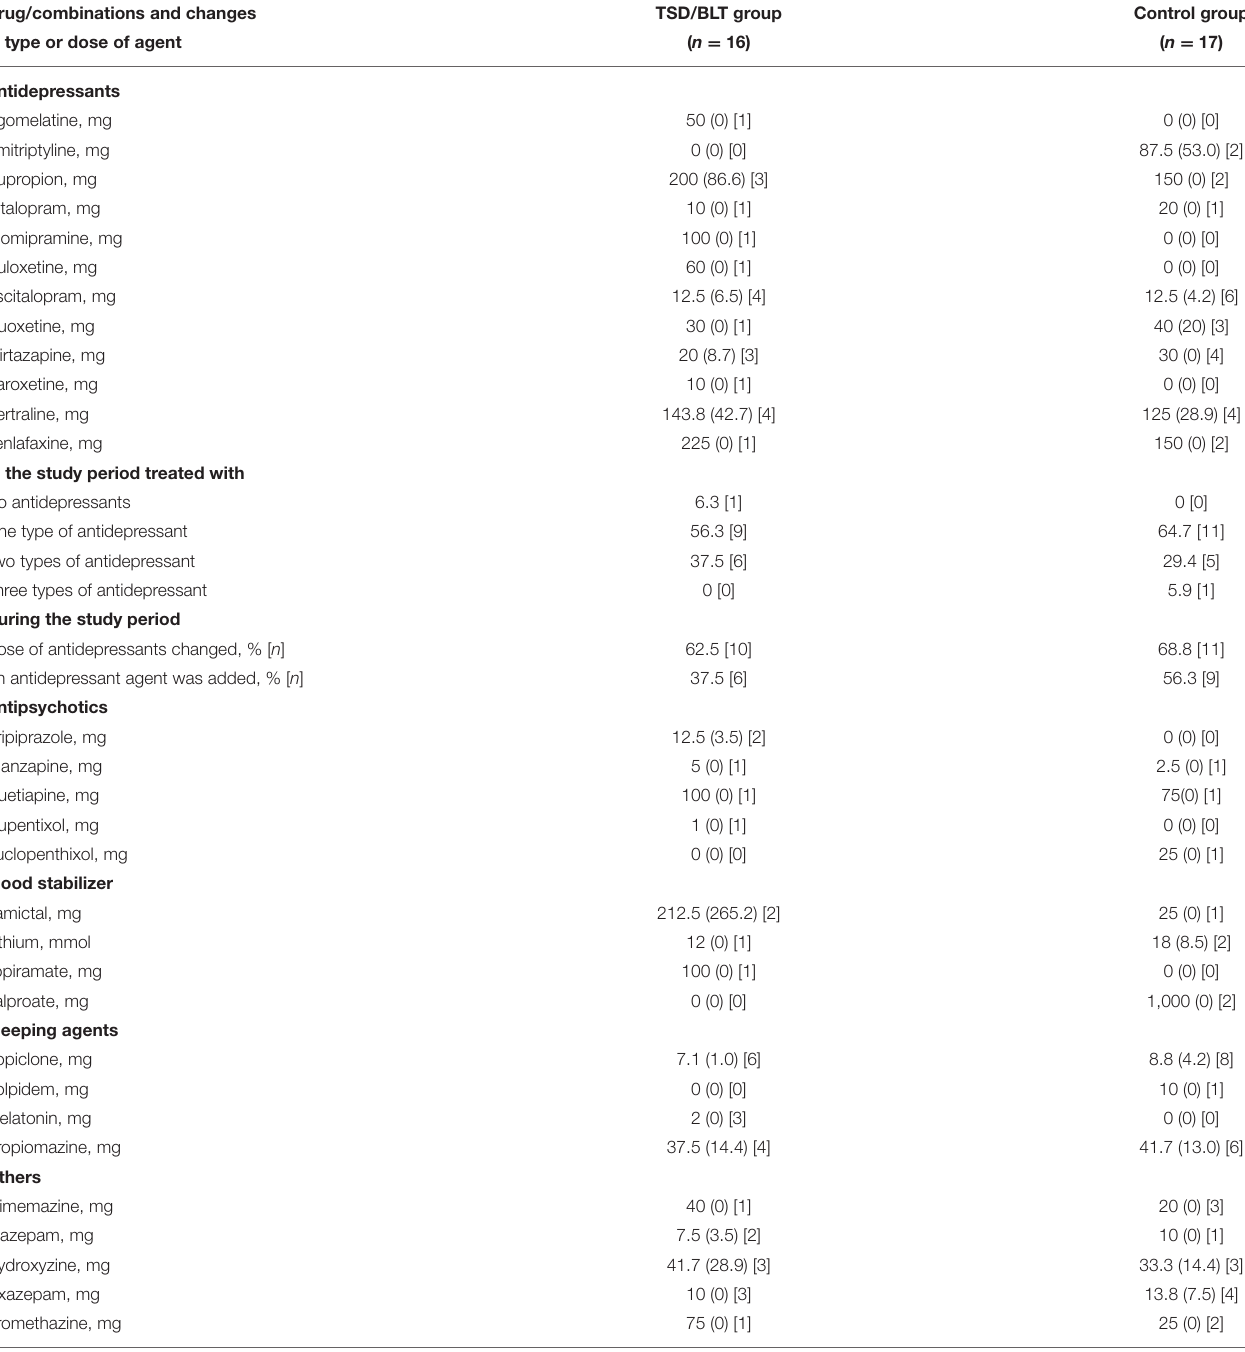
TABLE 3 | Mean daily dose of psychoactive medications by treatment group during study period. Combinations and changes in type or dose of agents. Drug/combinations and changes TSD/BLT